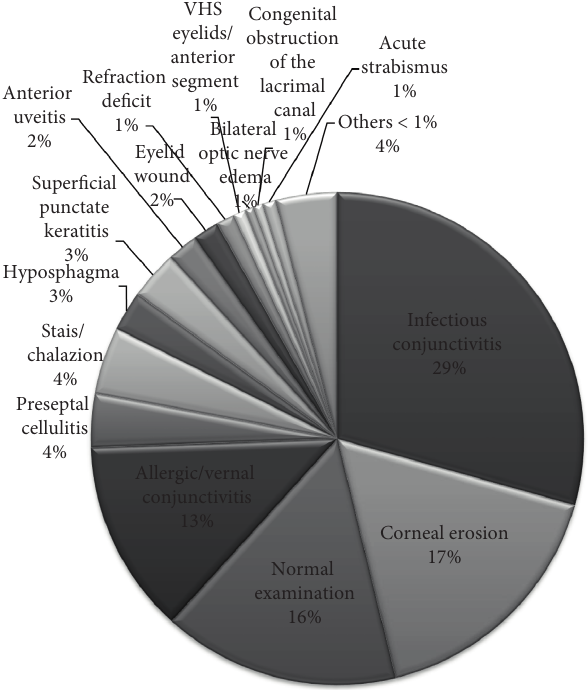
Figure 3: Most common final